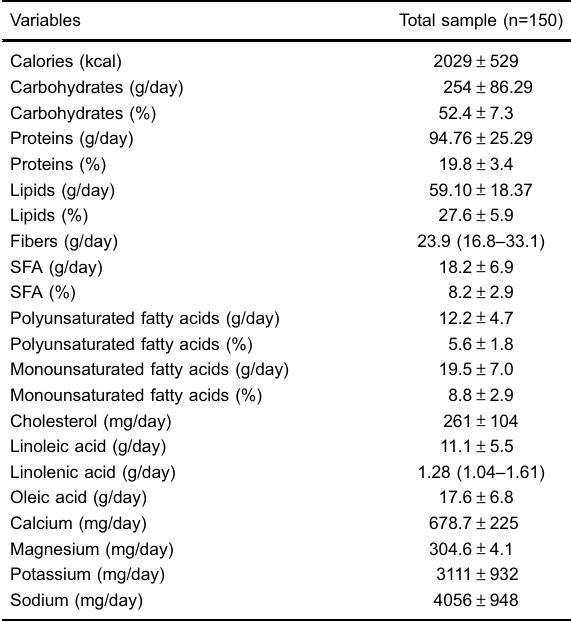
Table 2. Assessment of calorie, macronutrient, and micronutrient intake. Variables